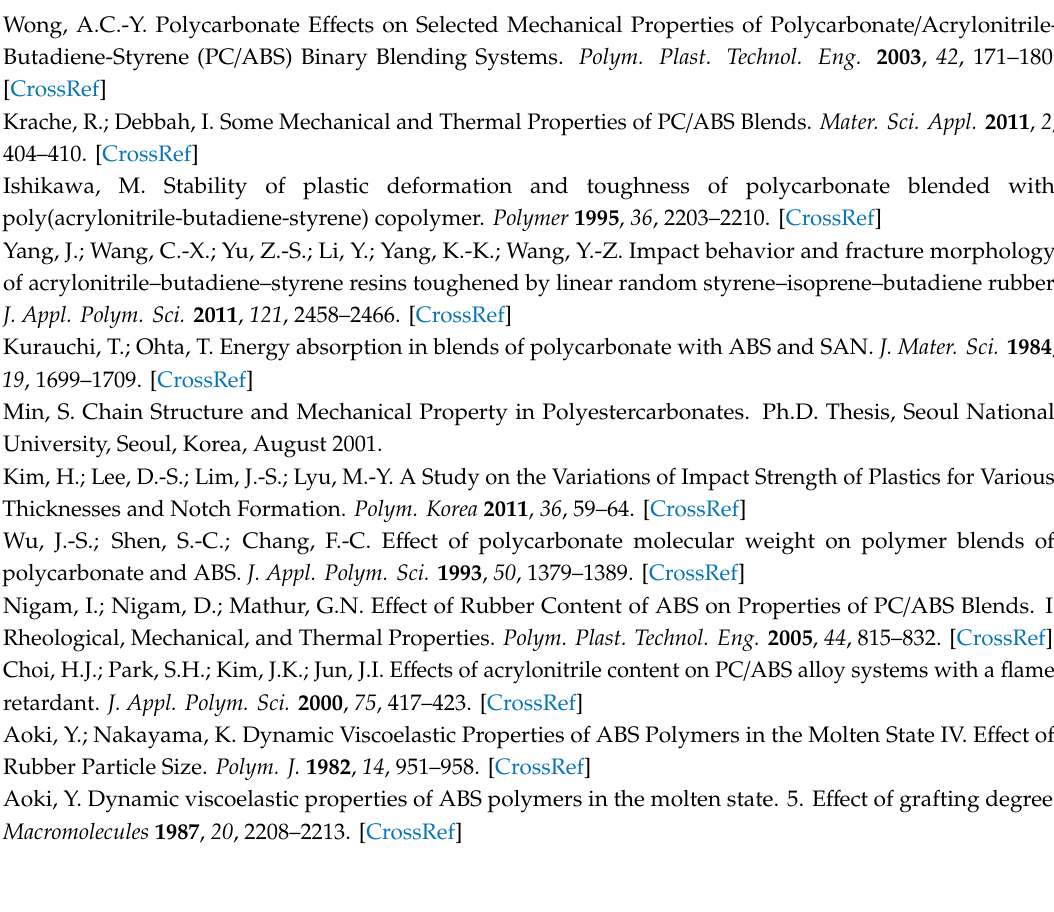
Figure S1. The phase change of PC / ABS blends examined by TEM for the blend ratio of (a–d) 5:5 and (e–h) 0:10; quenched to the room temperate right after time sweep measurement 3 with the frequency of (a,b) 0.1 rad / s, (c,d) 1 rad / s, and the images of (e–h) are obtained from 4 the same corresponding conditions. Figure S2. Viscosity curves of PC / ABS blends at the measuring temperature of (a) 240 ◦ C, 2 (b) 250 ◦ C, and (c) 260 ◦ C. Figure S3. The yield stress behavior of PC / ABS blends; (a) Casson plot of the blends with 2 whole frequency range at 250 ◦ C, (b) di ff erence in intercepts of the blends, (c) change of 3 yield stress values of the blends with increasing ABS content at given